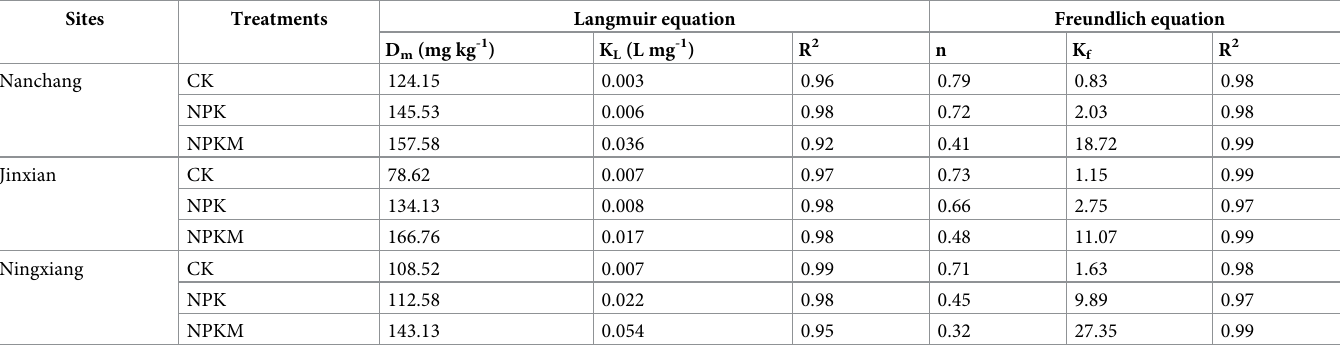
Table 5. P desorption isotherm parameters of the Langmuir and Freundlich models. Sites Treatments Langmuir